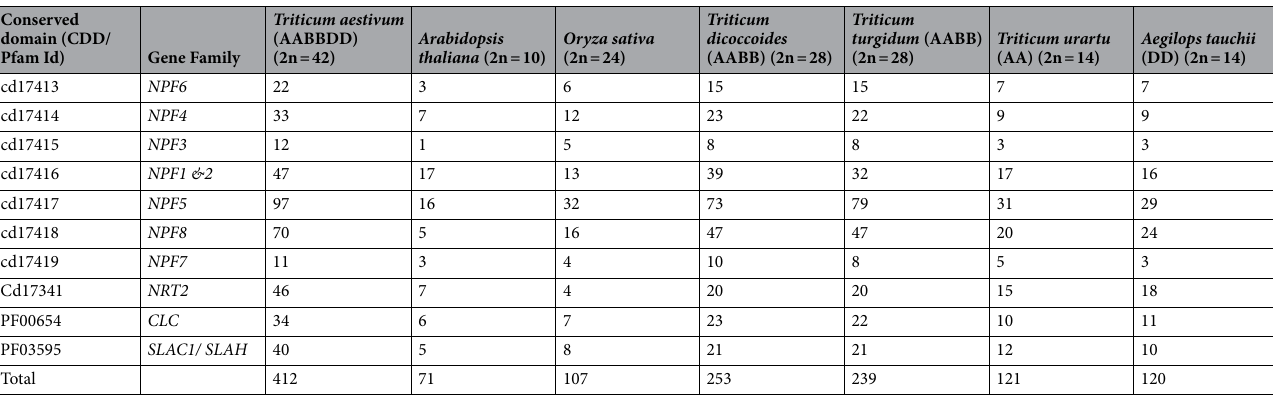
Table 1. Summary of nitrate transporter gene numbers in wheat, rice, Arabidopsis and wheat